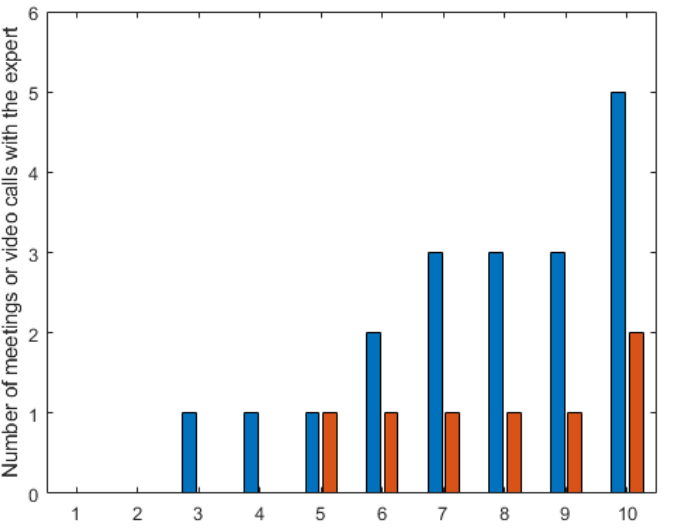
Figure 8. Number of meetings or video calls with the expert for individual participants. Blue bars— without the use of the HINT system, only paper documentation (information channels: text, overview photos) or physical contact with an expert. Red bars—with the use of the HINT system (information channels: text, overview photos, voice messages, overview video, remote contact with an expert). Data arranged in ascending order.